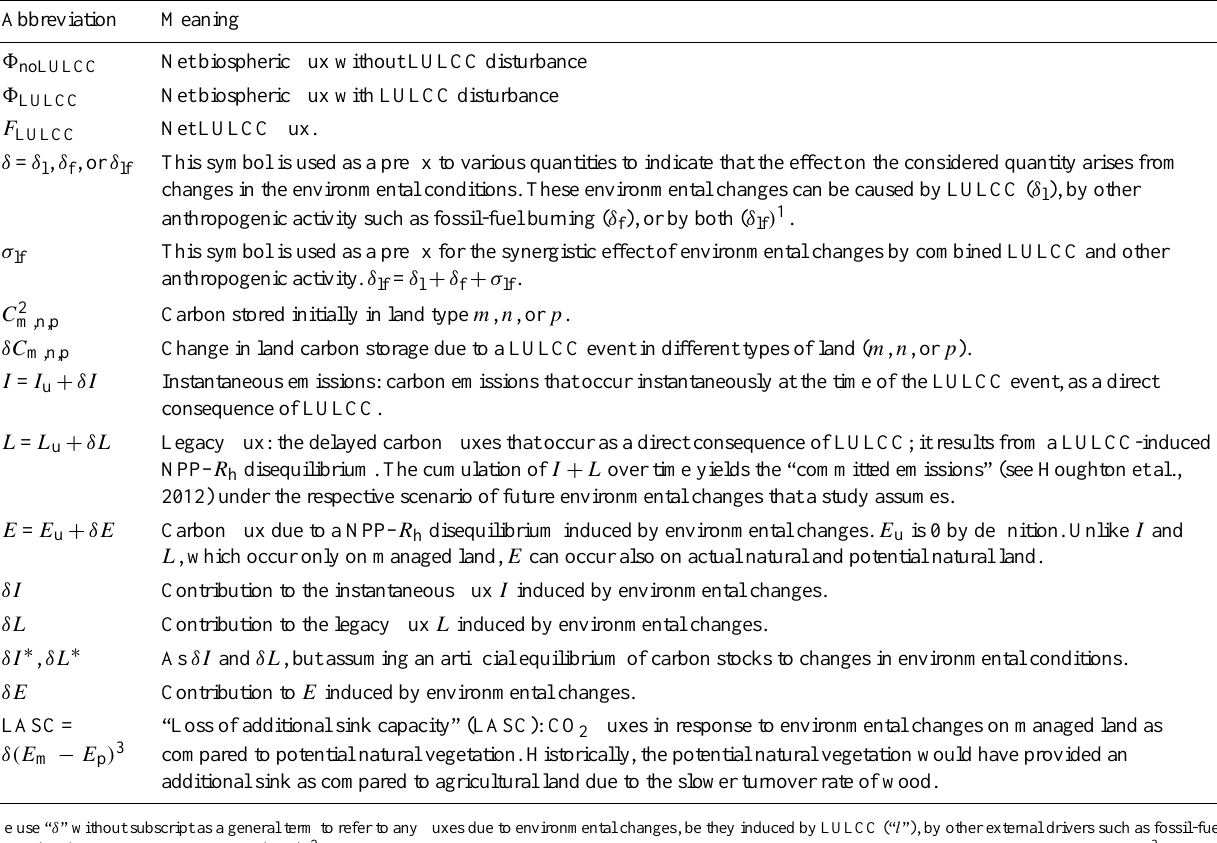
Table 1. Carbon stocks and fluxes used in our conceptual framework for comparison of published studies. See Table 2 for meaning of